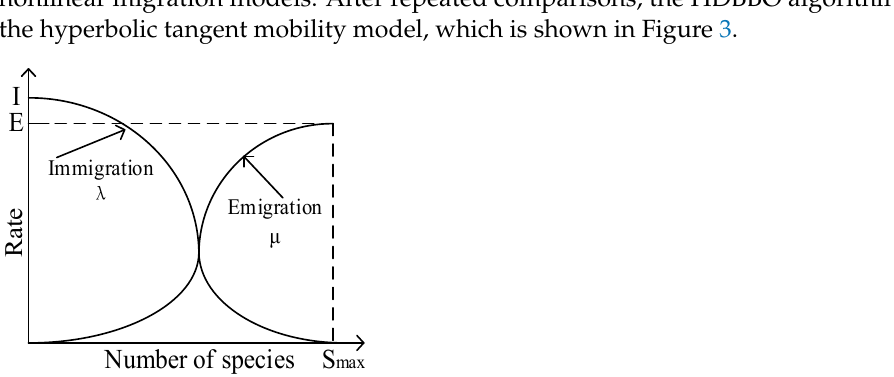
Figure 3. Hyperbolic tangent mobility model of species